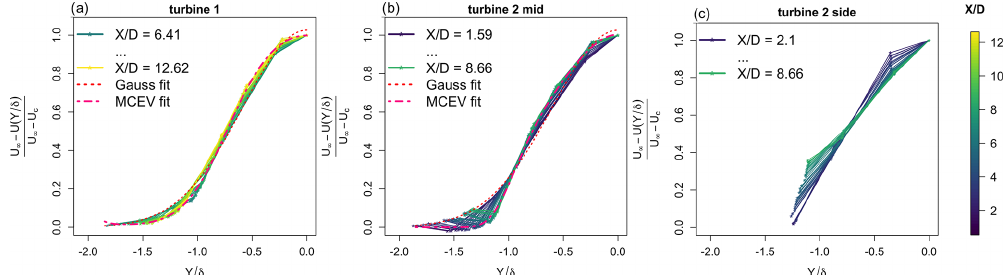
Figure 5. Plot of the wake deficit over the normalized spanwise position Y/δ for the three different inflow conditions: (a) turbine 1 – laminar inflow, (b) turbine 2 mid – turbulent inflow, (c) turbine 2 side – turbulent and intermittent inflow. Only curves in the decay region of the turbulence intensity are included, and the downstream position is indicated by means of the color